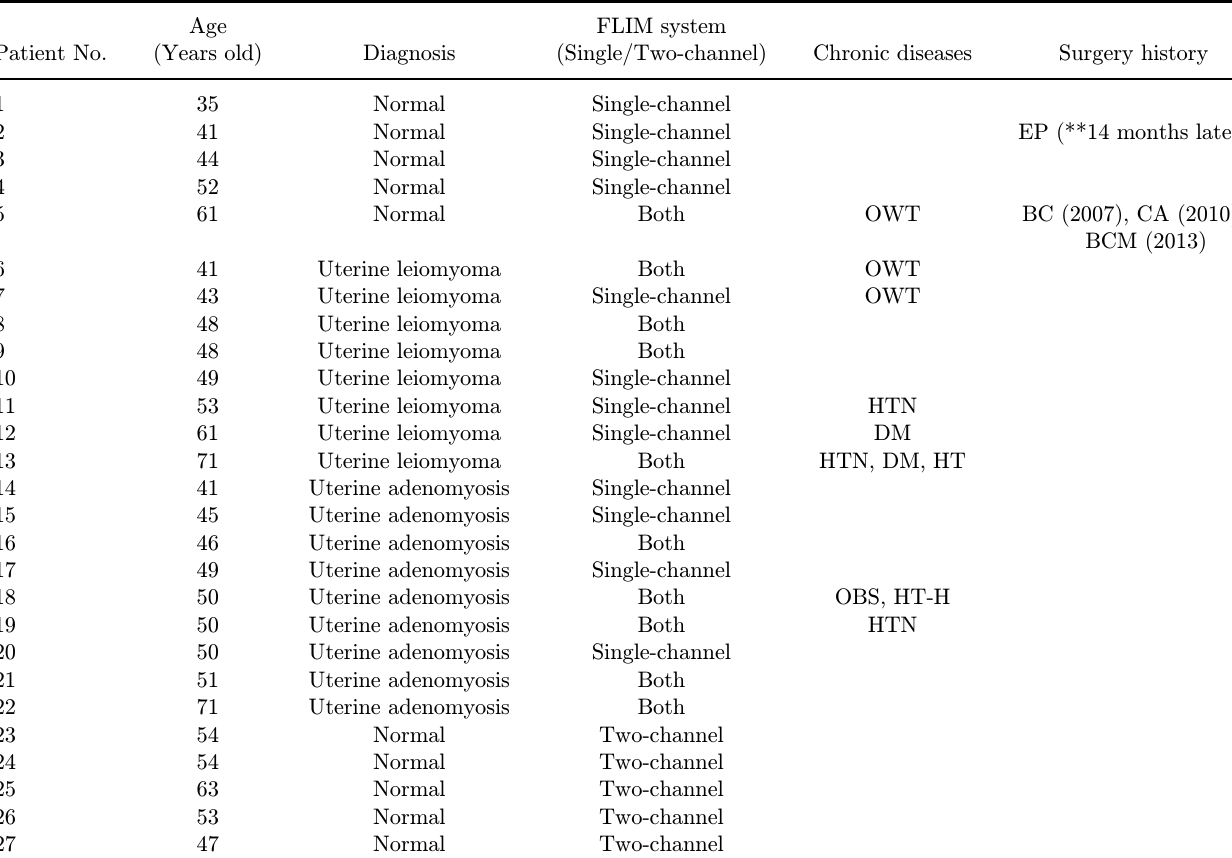
Table 1. Data of